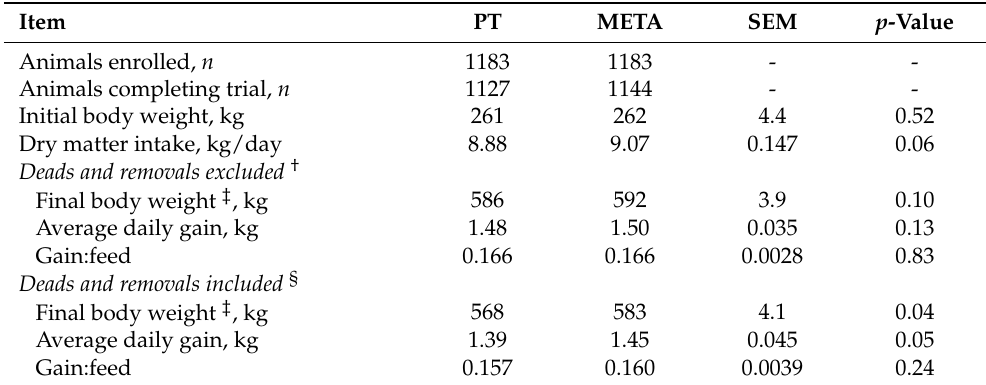
Table 3. Model adjusted means and standard errors of the mean (SEM) for feedlot performance outcomes of steers and heifers at medium risk for bovine respiratory disease (BRD) that received metaphylaxis (META) or a pull-and-treat (PT) health program for BRD